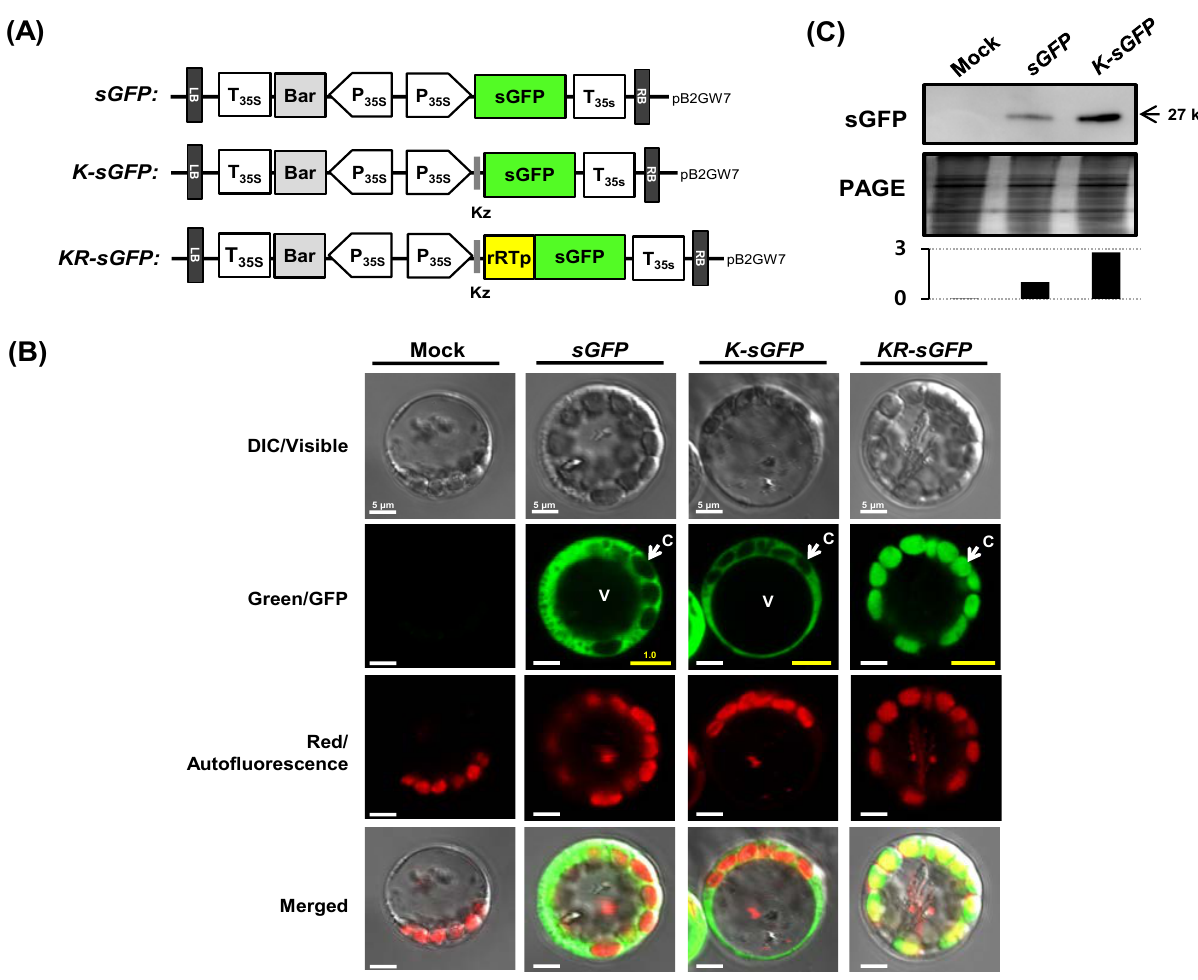
Figure 1. Subcellular localization and expression efficiency of sGFPs in rice protoplasts. ( A ) Three kinds of sGFP chimera were cloned into a pB2GW7 vector to construct sGFP , K-sGFP , and KR-sGFP for use in PEG-mediated transfection into rice protoplasts. Kz: Kozak sequence; rRTp: a transit peptide of rice RuBisCo small subunit; ( B ) Individual and merged images of GFP, chlorophyll autofluorescence, and visible protoplasts. C: chloroplast; V: vacuole. The images were acquired at 630× magnification using a confocal microscope. The yellow signals are the merged image of the green fluorescent signals from the sGFP proteins; the red fluorescent signals from chlorophyll in the chloroplasts. The PEG-transformed protoplasts with no plasmid were used as a mock sample. The yellow scale bars on the images show the mean intensity ratio of the green fluorescence signals (for 10 5 pixels), analyzed by a Histogram tool, and the white scale bars mean 5 μm and ( C ) The expression efficiency of proteins was compared using western blot analysis. Polyclonal rabbit antibody against sGFP was used at a titer of 1:5000 and the image of PAGE gel was used to show relative quantities of the loaded proteins. The graph shows the relative band intensities that were quantified using LAS4000